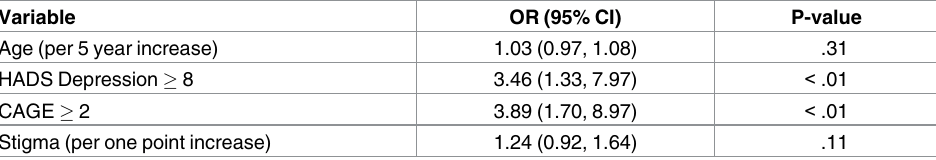
Table 5. Predictors of disengagement from care—multivariable logistic regression a (n = 136).